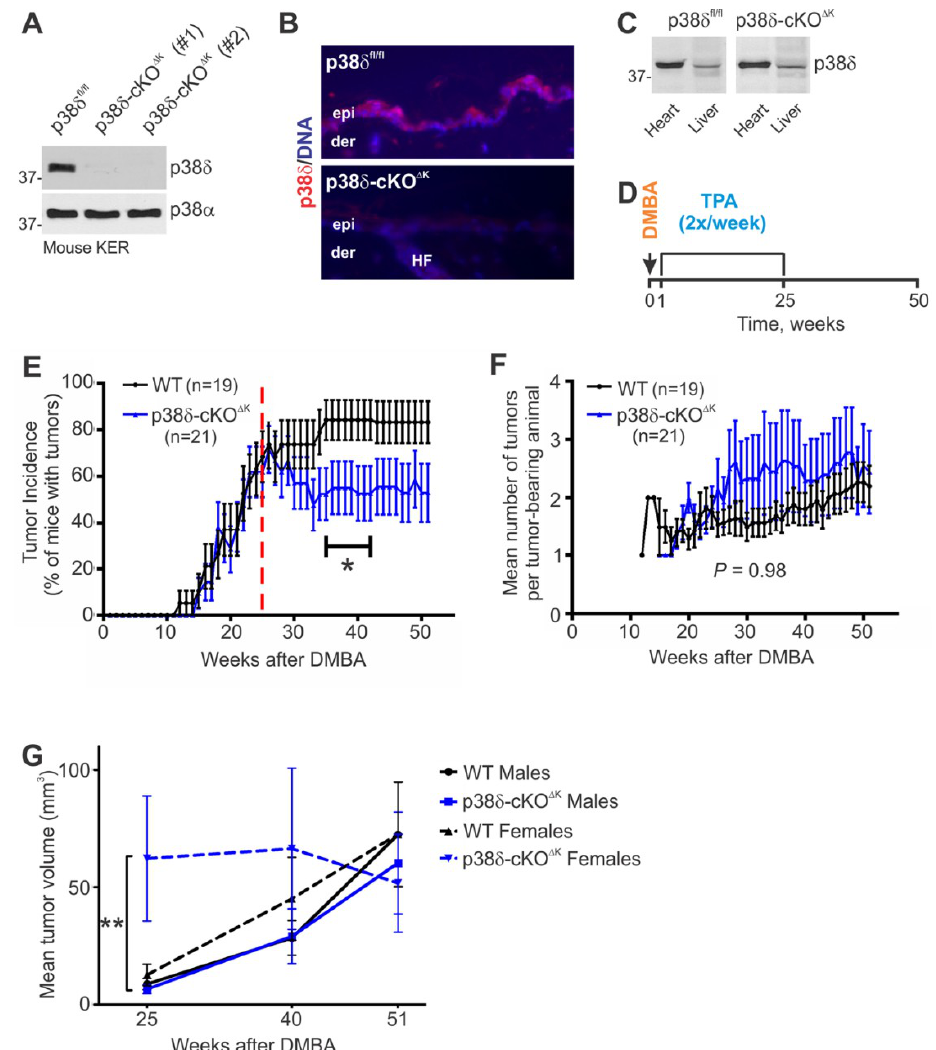
Figure 1. The effects of keratinocyte p38δ deficiency on skin tumor development. ( A ) Immunoblot analysis of p38 δ and p38 α expression in total cell extracts prepared from cultured mouse analysis of p38δ and p38α expression in total cell extracts prepared from cultured mouse keratinocytes isolated from newborn WT control (p38 δ fl/fl ) and mutant (p38 δ -cKO ∆ K , #1 and #2) keratinocytes isolated from newborn WT control (p38δ fl/fl ) and mutant (p38δ-cKO ΔK , #1 and #2) littermates. ( B ) Immunofluorescence analysis of p38 δ expression in p38 δ fl/fl and p38 δ -cKO ∆ K littermates. ( B ) Immunofluorescence analysis of p38δ expression in p38δ fl/fl and p38δ-cKO ΔK adult mouse epidermis. Skin sections from eight-week-old mice were stained with antibody against p38δ. Nuclei were counterstained with Hoechst. Epi, epidermis; der, dermis; HF, hair follicle. Representative tissue fields. Magnification, 20×. ( C ) Immunoblot analysis of p38δ expression in heart and lung tissue lysates from p38δ fl/fl and p38δ-cKO ΔK littermate mice. ( D ) Schematic depicting the